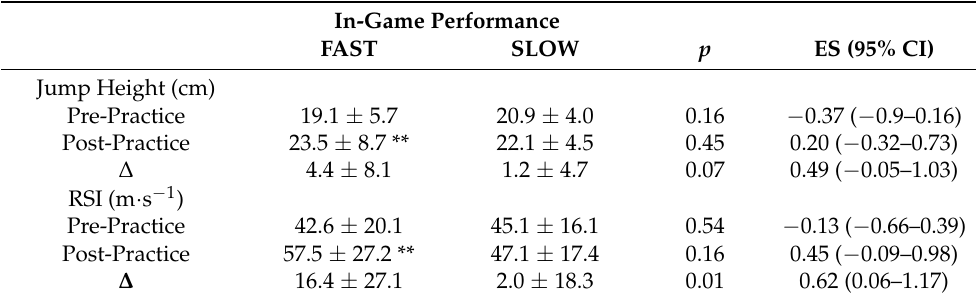
Table 1. Repeated-hop descriptive data from Match-Day -1 and comparison between FAST and SLOW in-game